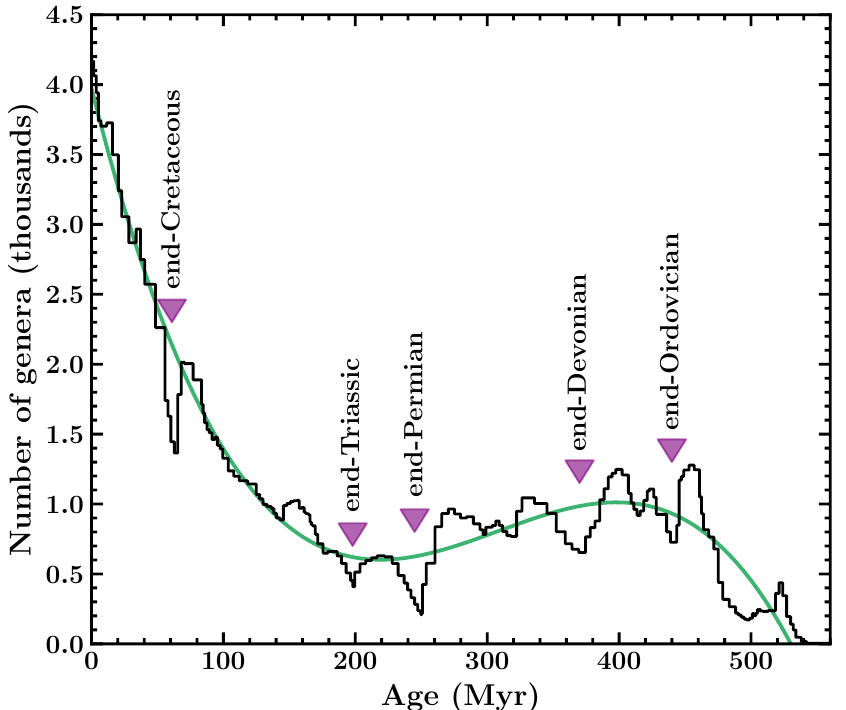
Figure 1. Number of genera (black histogram) over time for the 17,797 well-resolved known marine animal genera of Sepkoski’s Compendium of Fossil Marine Animal Genera [26]. The green curve is a least square fit to the data points, and vertical triangles mark the 5 MEs which occurred on Earth in the last 500